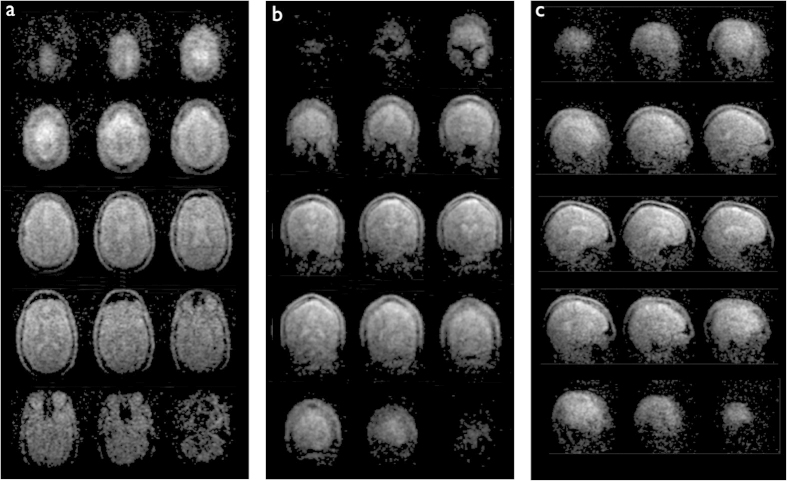
3D images of the living brain acquired in 6 minutes at 6.5 mT in (a) axial, (b) coronal, and (c) sagittal orientation. The corresponding maximum SNRs are a. 15, b. 21, and c. 16. Acquisition matrix: 64 × 75 × 15, voxel size: a. (2.5 × 3.5 × 8.5) mm3, b. (2.5 × 3.5 × 11.5) mm3, and c. (2.5 × 3.5 × 14.4) mm3.